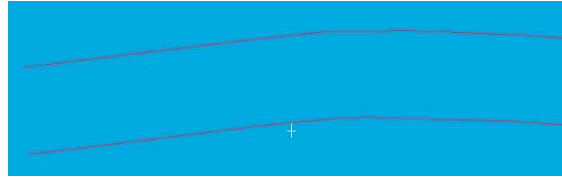
Figure 7. Refining based on road continuity